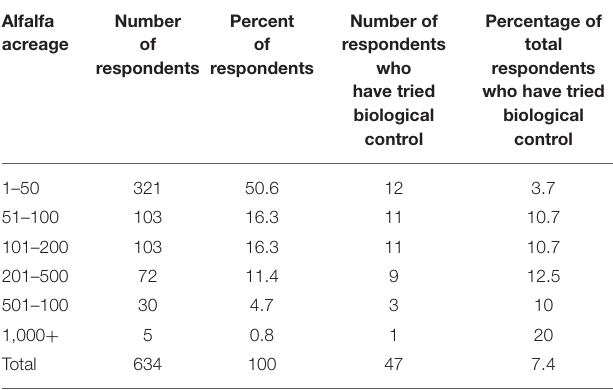
TABLE 3 | Growers who have tried biological control by farm